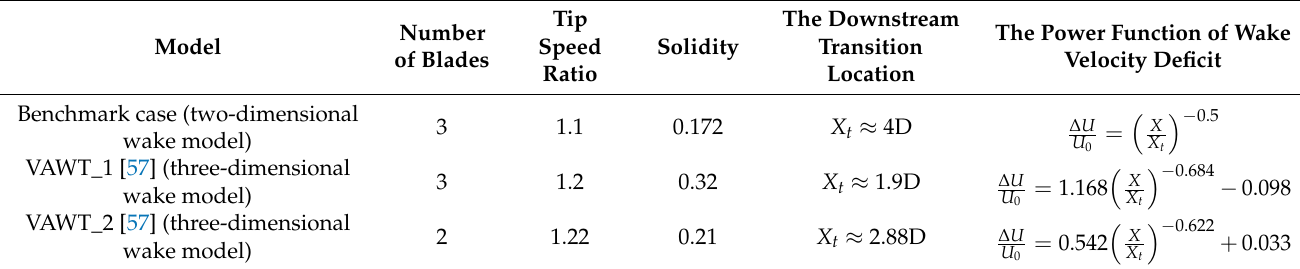
Table 3. The parameters of these three vertical axis wind turbine (VAWT) wake models.